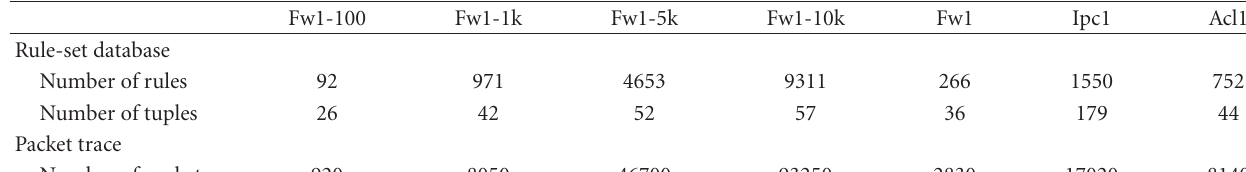
Table 1: Rule-set database and packet trace specification.